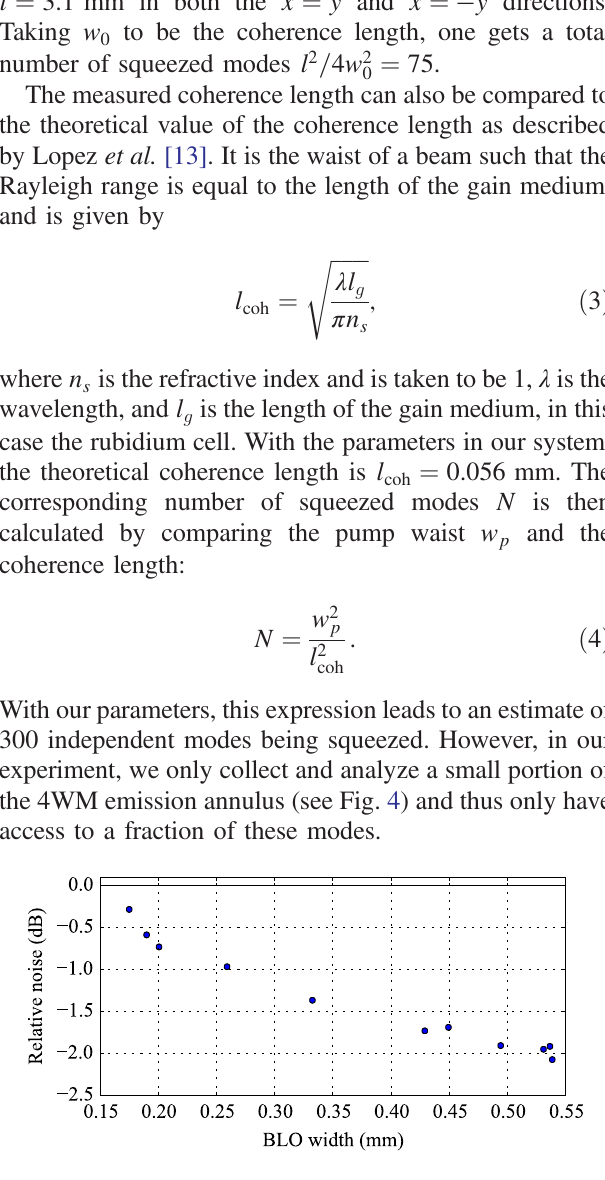
FIG. 8. Quantum-noise reduction as a function of the width of the